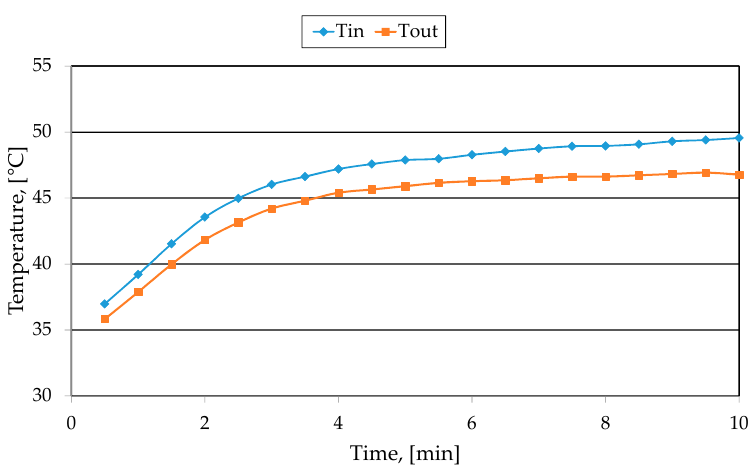
Figure 3. Time evolution of evaporator inlet and outlet average temperatures.